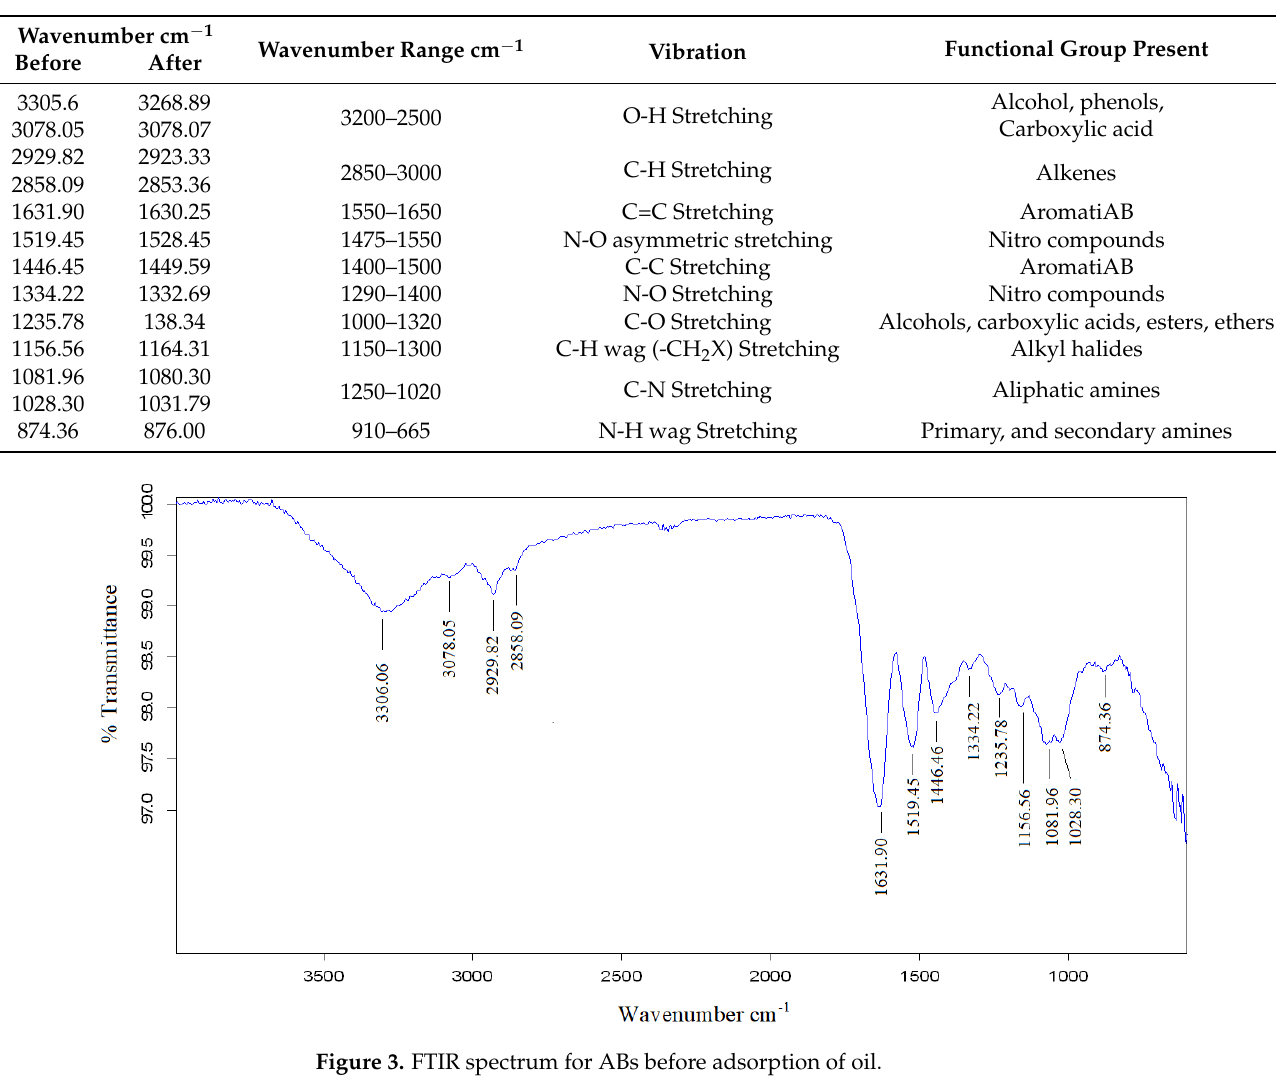
Table 1. FTIR spectrum of AB adsorbents before and after the adsorption process of oil.